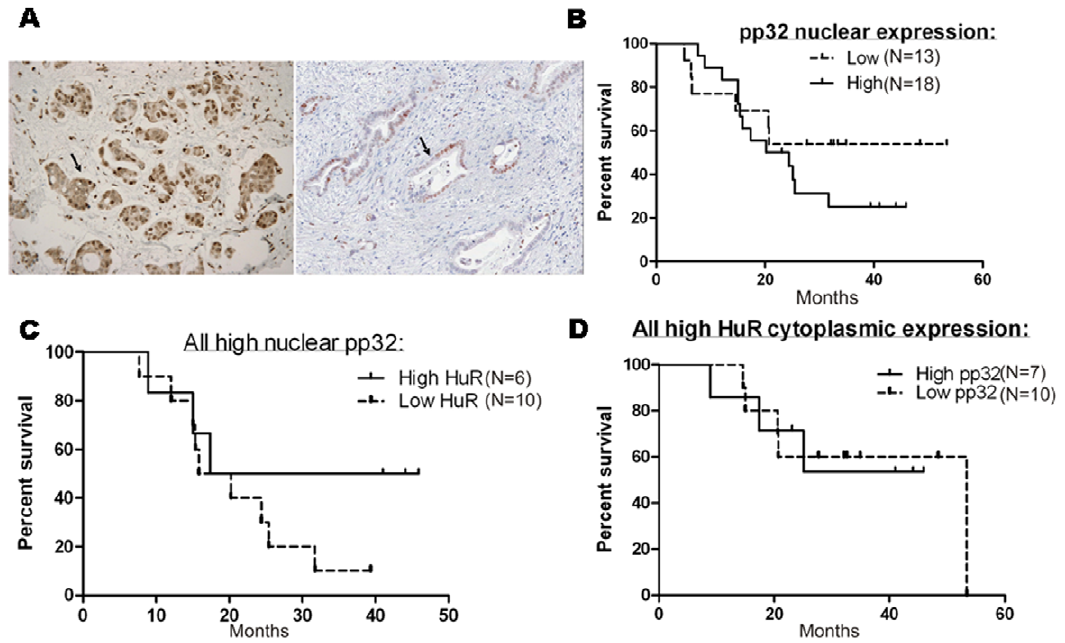
Figure 6. pp32 and HuR expression in clinical samples and patient outcomes. (A) The abundance and subcellular localization of HuR ( left ) and low to absent nuclear pp32 expression ( right ) in samples from pancreatic cancer patients were assessed by immunohistochemistry; magnification, 200x. Samples are representative of the cohort analyzed in B–D. (B) Correlation between pp32 nuclear expression and response to GEM treatment (p=0.3, log rank test). (C) Correlation between high nuclear pp32-expressing tumor samples stratified into high or low HuR status in regards to GEM response (p=0.88, log rank test). (D) Correlation between high cytoplasmic HuR-expressing tumor samples stratified into high and low pp32 nuclear expression correlated with GEM response (p=0.25, log rank test).